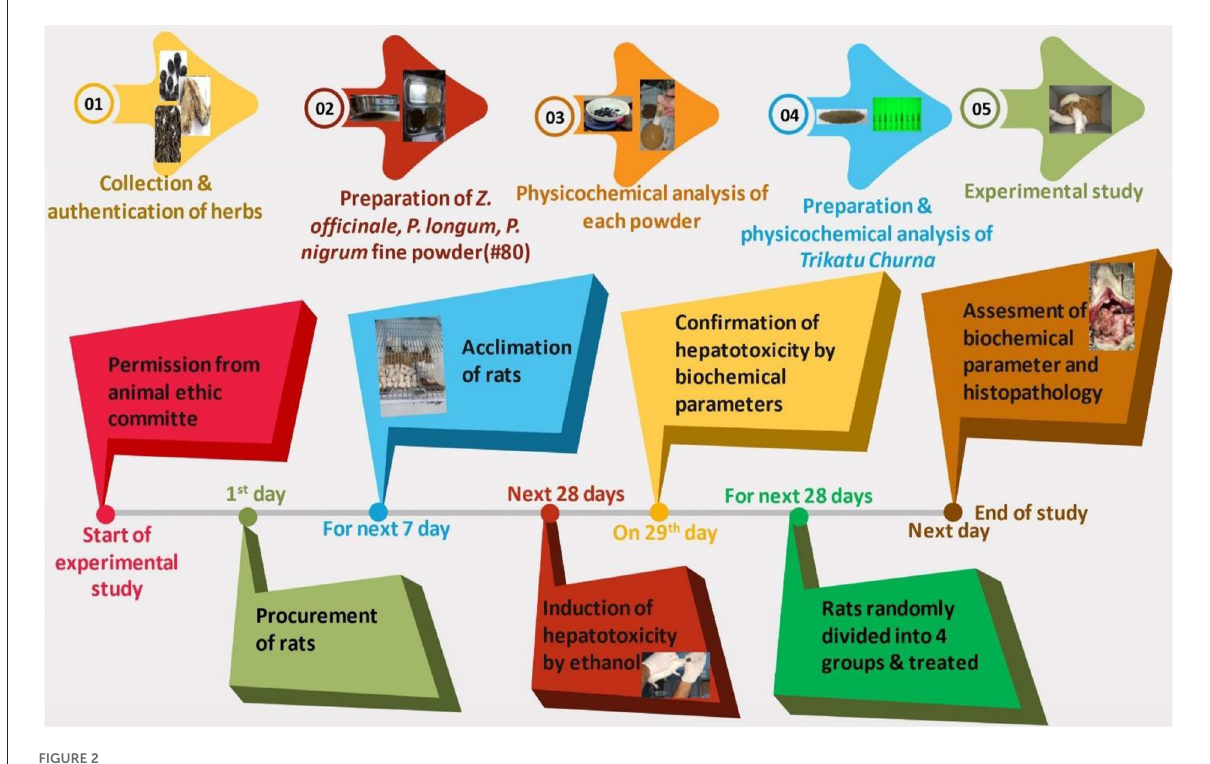
FIGURE2 Protocol of the experimental study.